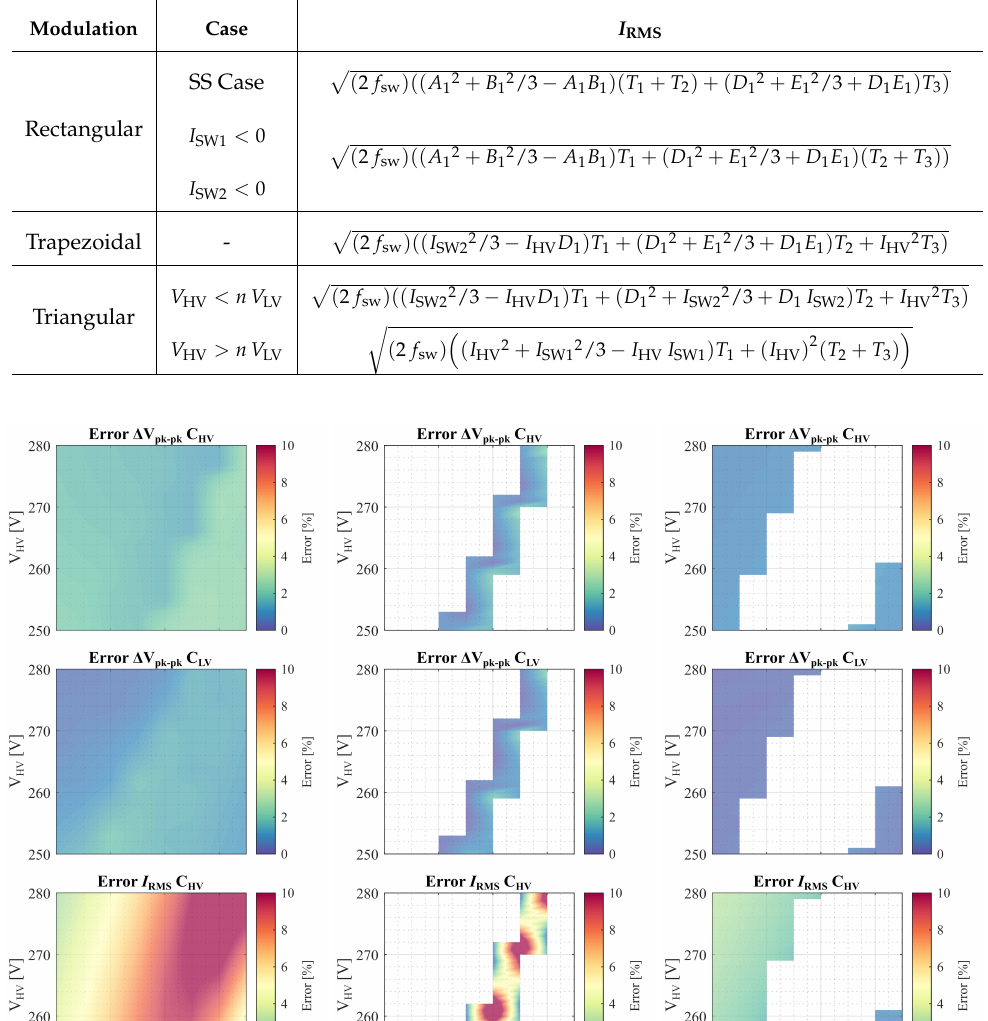
Table A2. RMS Current in input capacitor (power transfer from HV to LV).